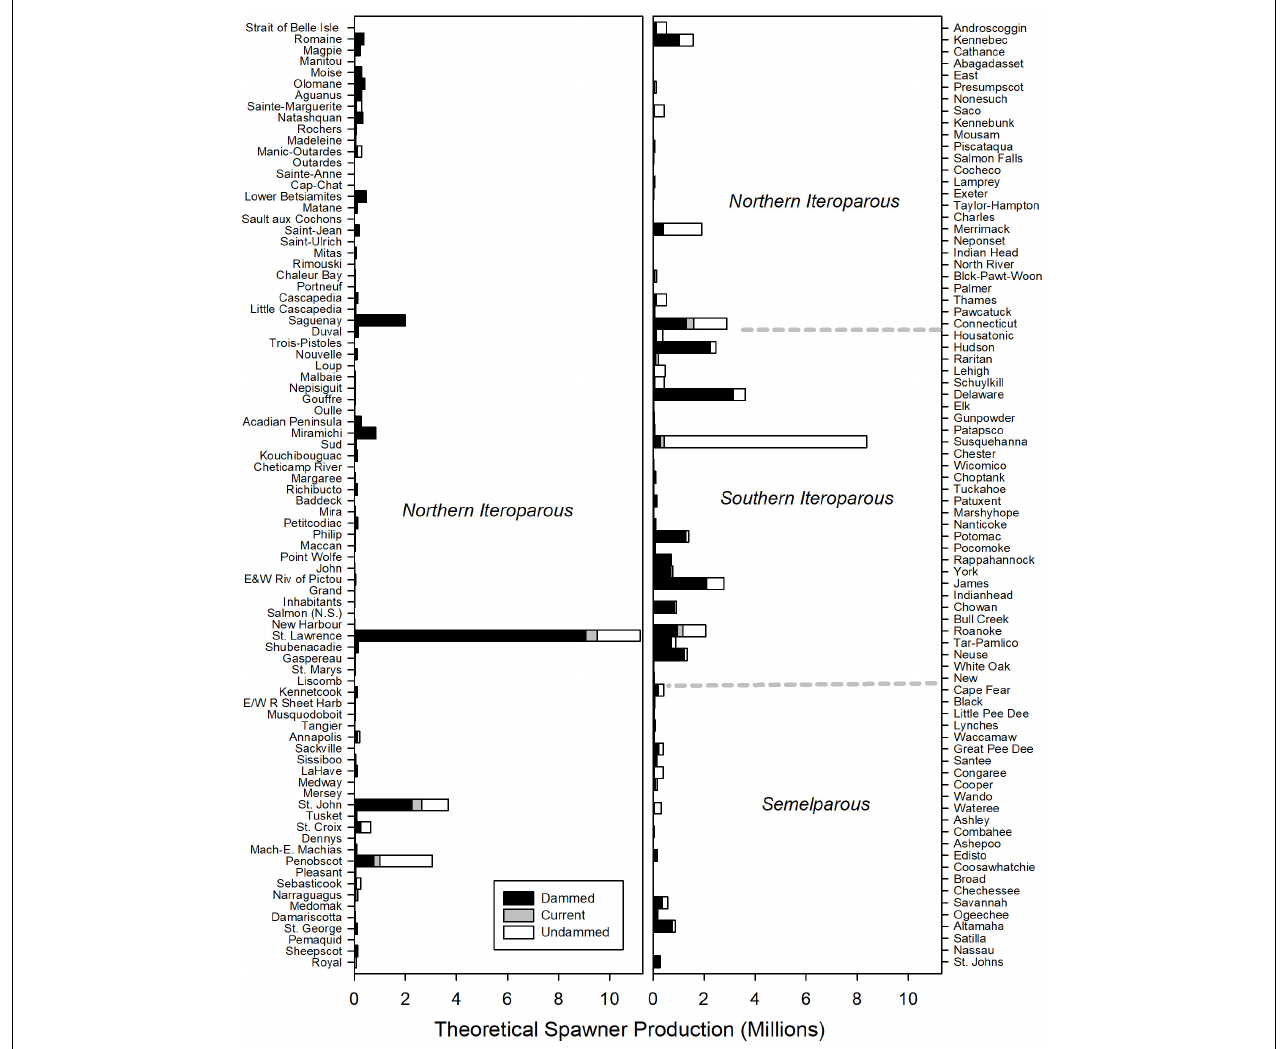
FIGURE 7 | Estimated spawning potential of American shad for each river through their native range from Canada to Florida. Dotted lines indicate transitions between Eco-regions regions. Rivers ( y -axes) are ordered in descending latitude. The stacked bars depict estimated potential for the No Passage, Current and Undammed